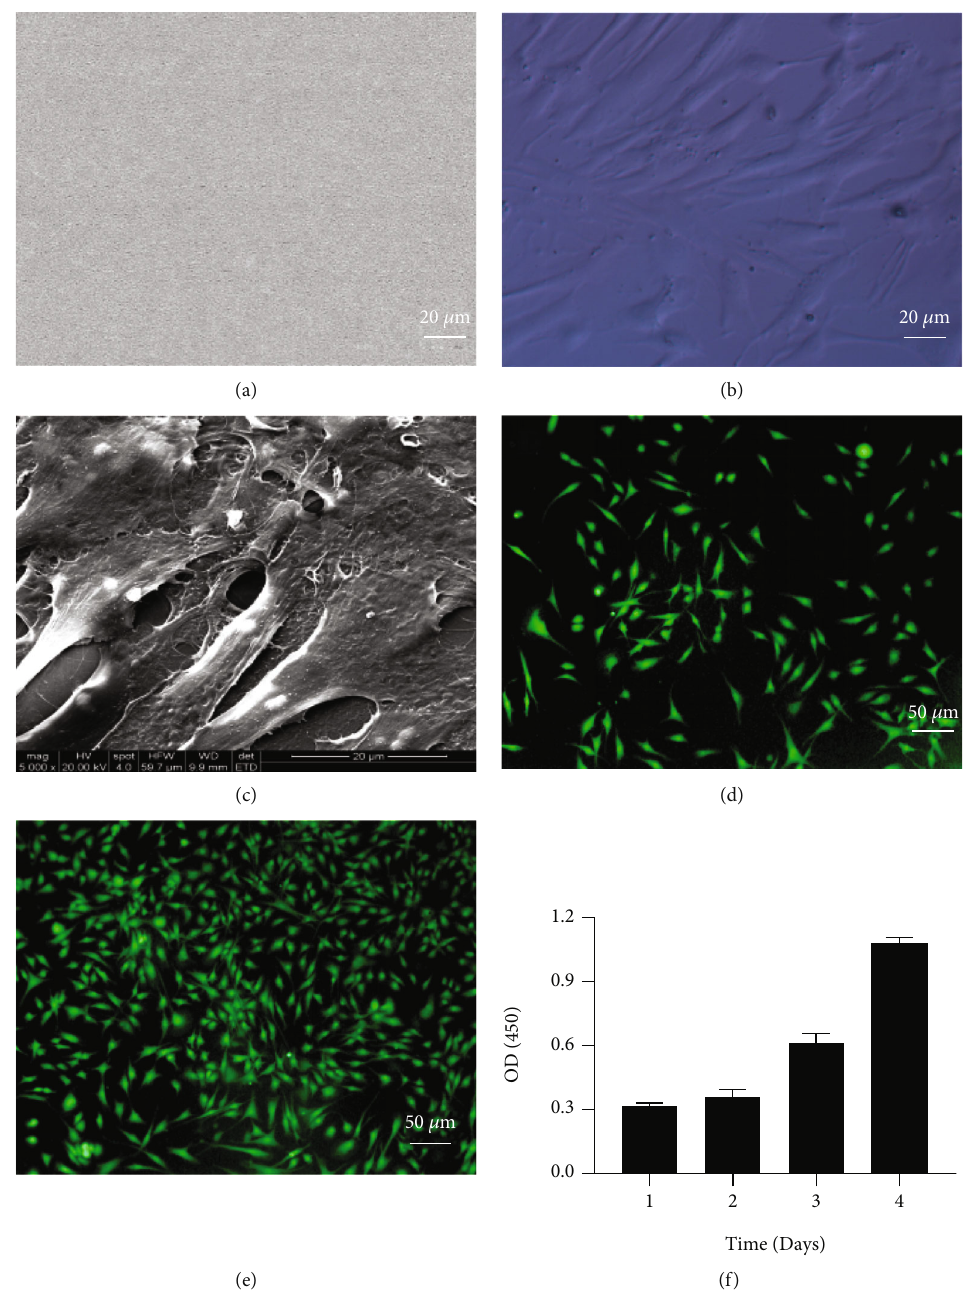
Figure 2: Morphological characteristics of EMSCs and the GC sca ff old. (a) SEM images of the morphology of the GC sca ff old. (b, c) Image of EMSCs in the GC sca ff old as seen by optical microscopy (b) and SEM (c). (d, e) The viability of EMSCs in the GC sca ff old was assessed using live/dead staining on day 2 (d) and day 5 (e) (green: live cells). (f) The cell proliferation ability was determined by the CCK8